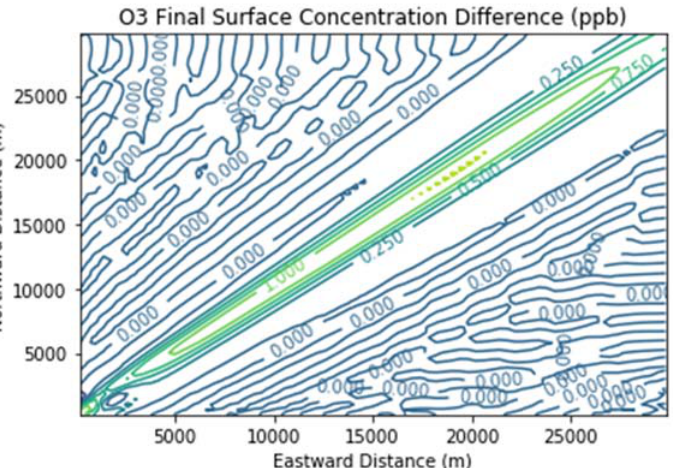
Figure 7. Ozone difference plot between the Combustion Only and Baseline scenarios at the end of the 3 h simulation for the 30 km × 30 km domain.